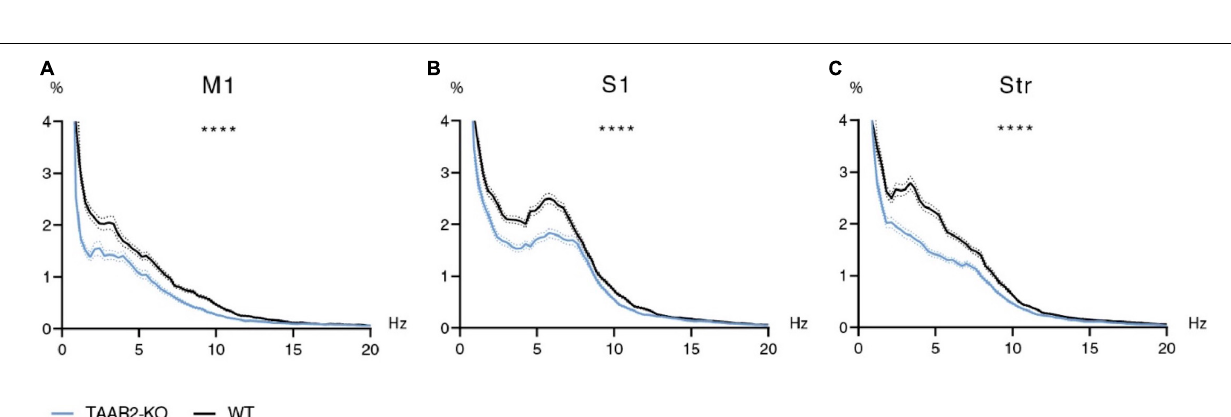
Frontiers in Behavioral Neuroscience |